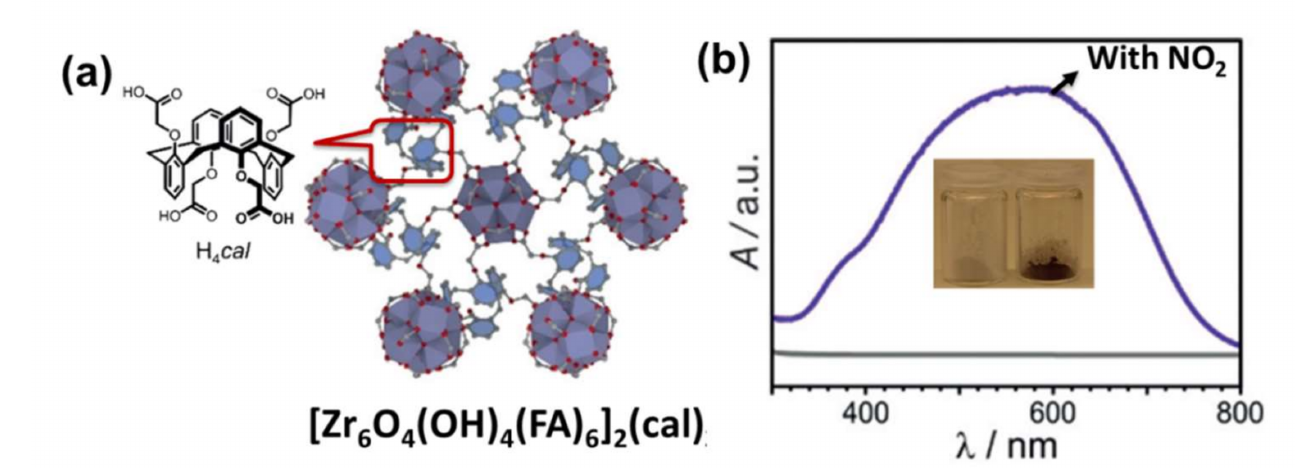
Figure 7. ( a ) The structure of [Zr 6 O 4 (OH) 4 (FA) 6 ] 2 (cal) 3 . ( b ) The luminescence intensity changes of [Zr 6 O 4 (OH) 4 (FA) 6 ] 2 (cal) 3 before and after bubbling of NO 2 . Adapted from